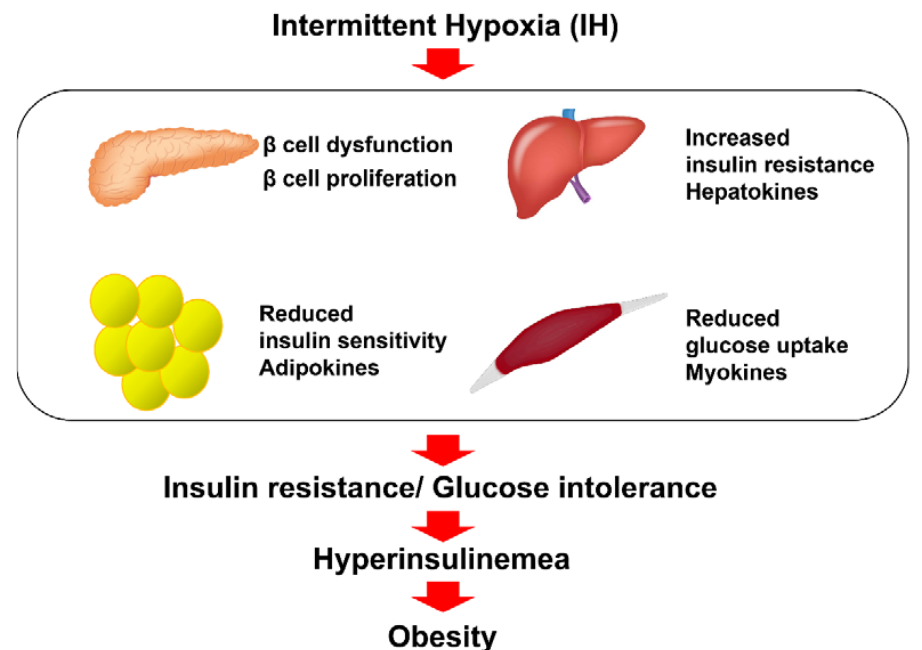
Figure 1. The relationship between IH and insulin resistance, glucose intolerance, and diabetes. IH, frequently observed in SAS patients, is involved in the reduction in glucose-induced insulin secretion from pancreatic β cells via down-regulation of CD38 [6]; up-regulation of Reg I and hepatocyte growth factor in pancreatic β cells [76]; up-regulation of selenoprotein P and HIP/PAP in hepatocytes via down-regulation of miR-203 [5]; up-regulation of adipokines, such as CCL2, TNF- α , and RETN in adipocytes via down-regulation of miR-452 [78]; and up-regulation of myokines, such as IL-8, osteonectin, and myonectin in skeletal muscle cells [79–81], all of which can contribute to insulin resistance, glucose intolerance, and obesity [82].